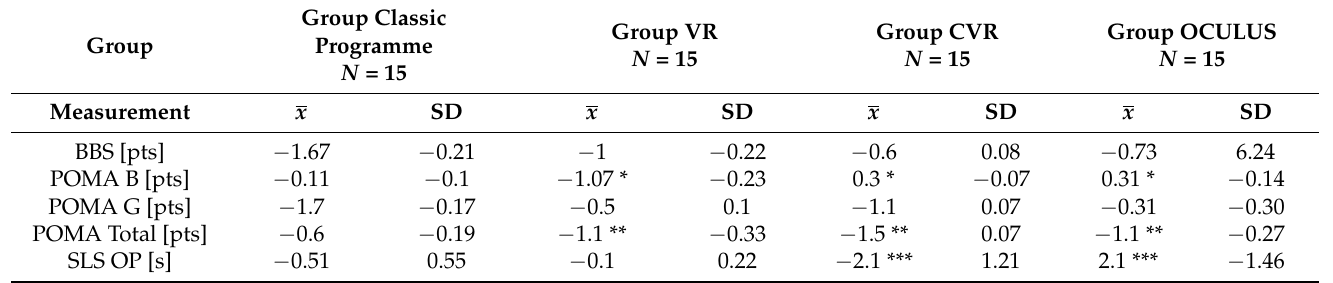
Table 4. The differences in the tests specifically addressing balance, as noted between respective measurement